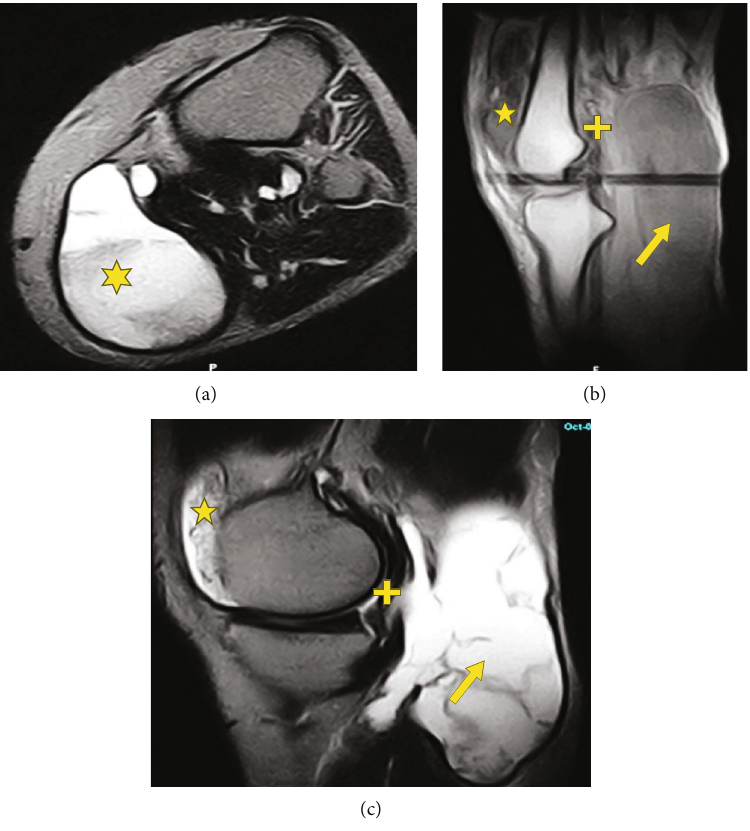
Figure 10: Axial and sagittal images of a 55-year-old male with D-TGCT in the knee. (a) MRI with axial T2 fat suppressed images of the proximal lower leg. The large posteromedial hyperintense mass (star) shows a fl uid- fl uid level from the synovial fl uid in the anterior aspect and proteinaceous and bloody fl uid posteriorly. (b) MRI sagittal T1 view of the knee. Anteriorly, (star) the suprapatellar pouch is fi lled with an intermediate intensity fl uid and contains di ff use hypointense material characteristic for the solid component of tenosynovial giant cell tumor. Posterior to the joint, there are multiple aggregations of hypointense masses along the posterior capsule and origins of the gastrocnemius muscles and the posterior cruciate ligament. Posteriorly, (arrow) the enormous popliteal cyst is evident with intermediate intensity. (c) MRI with sagittal T2 fat suppressed images of the knee. This shows the same fl uid fi lled suprapatellar pouch with di ff use areas of lower intensity scattered throughout (star). Di ff use dark bands of thickened posterior capsule and tumor extend outside the joint and behind the posterior cruciate ligament (plus). The large hyperintense fl uid fi lled popliteal cyst with scattered hypointense bands and nodules are present posteriorly